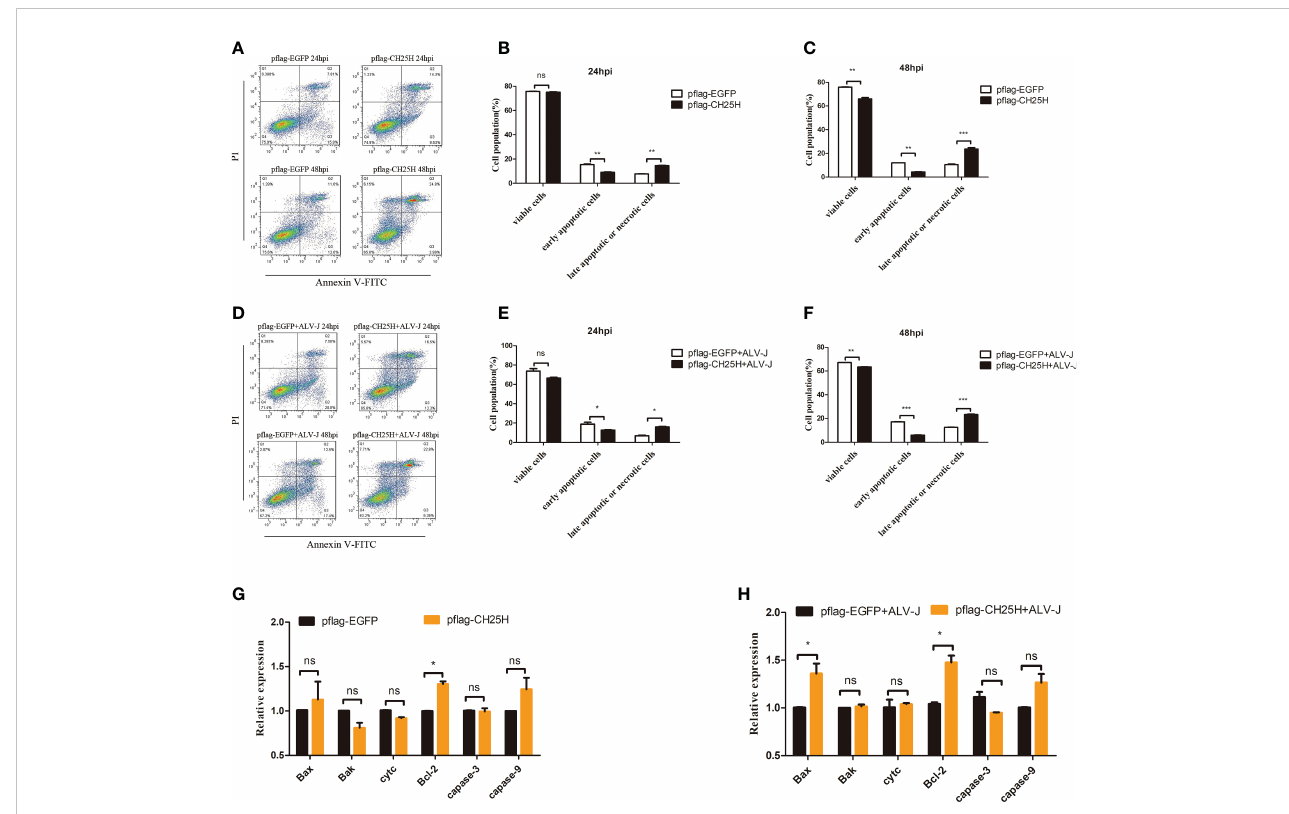
FIGURE 2 CH25H induces activation of programmed cell death. (A) DF-1 cells were transfected with p fl ag-CH25H and control plasmid p fl ag-EGFP for the indicated time, cell apoptosis was detected after AnnexinV FITC/PI labeling by fl ow cytometry, respectively. (B, C) Statistical analysis of viable cells, early apoptotic cells, late apoptotic cells or necrotic cells rate. (D) DF-1 cells were transfected with p fl ag-CH25H or p fl ag-EGFP for 24 h and infected with ALV-J (10 5 TCID 50 /0.1mL), cell apoptosis was detected after AnnexinV FITC/PI labeling by fl ow cytometry at 24 and 48 h infection. (E, F) Statistical analysis of viable cells, early apoptotic cells, late apoptotic cells or necrotic cells rate. (G) DF-1 cells were transfected with p fl ag-CH25H and control plasmid p fl ag-EGFP for 48 h, qRT-PCR analysis of the mRNA expression of apoptosis-related genes ( Bax , Cyt c , Caspase-3 , Caspase-9 , Bak , Bcl-2 and Bcl-xl ). (H) DF-1 cells that were transfected with p fl ag-CH25H or p fl ag-EGFP were infected with ALV-J at 24 h. At 48 hpi, qRT-PCR analysis of the mRNA expression of apoptosis-related genes ( Bax , Cyt c , Caspase-3 , Caspase-9 , Bak , and Bcl-2 ). hpi represents hours post infection. Data shown are the means ± SEM of at least two independent experiments. P values were calculated using unpaired Student ’ t -test. A P -values < 0.05 were considered statistically signi fi cant differences, and a P -values < 0.01 were considered highly statistically signi fi cant differences. * P < 0.05, ** P < 0.01, *** P < 0.001, ns: Non-signi fi